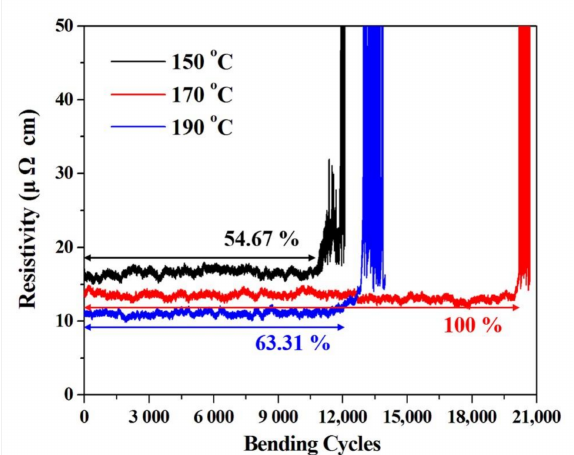
Figure 7. Bending durability result of the silver electrode fabricated according to the curing temperature.